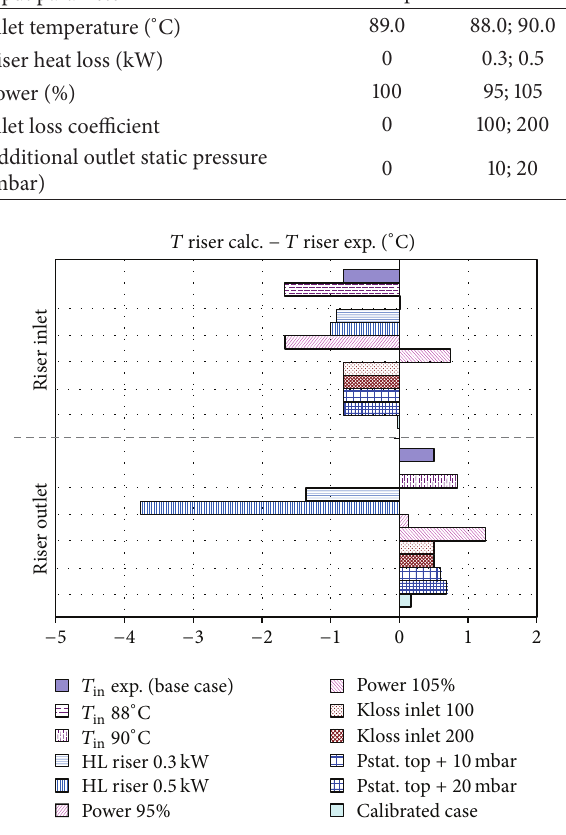
Figure 6: Difference between calculated and experimental temper- ature in the riser. Steady state test S-1.